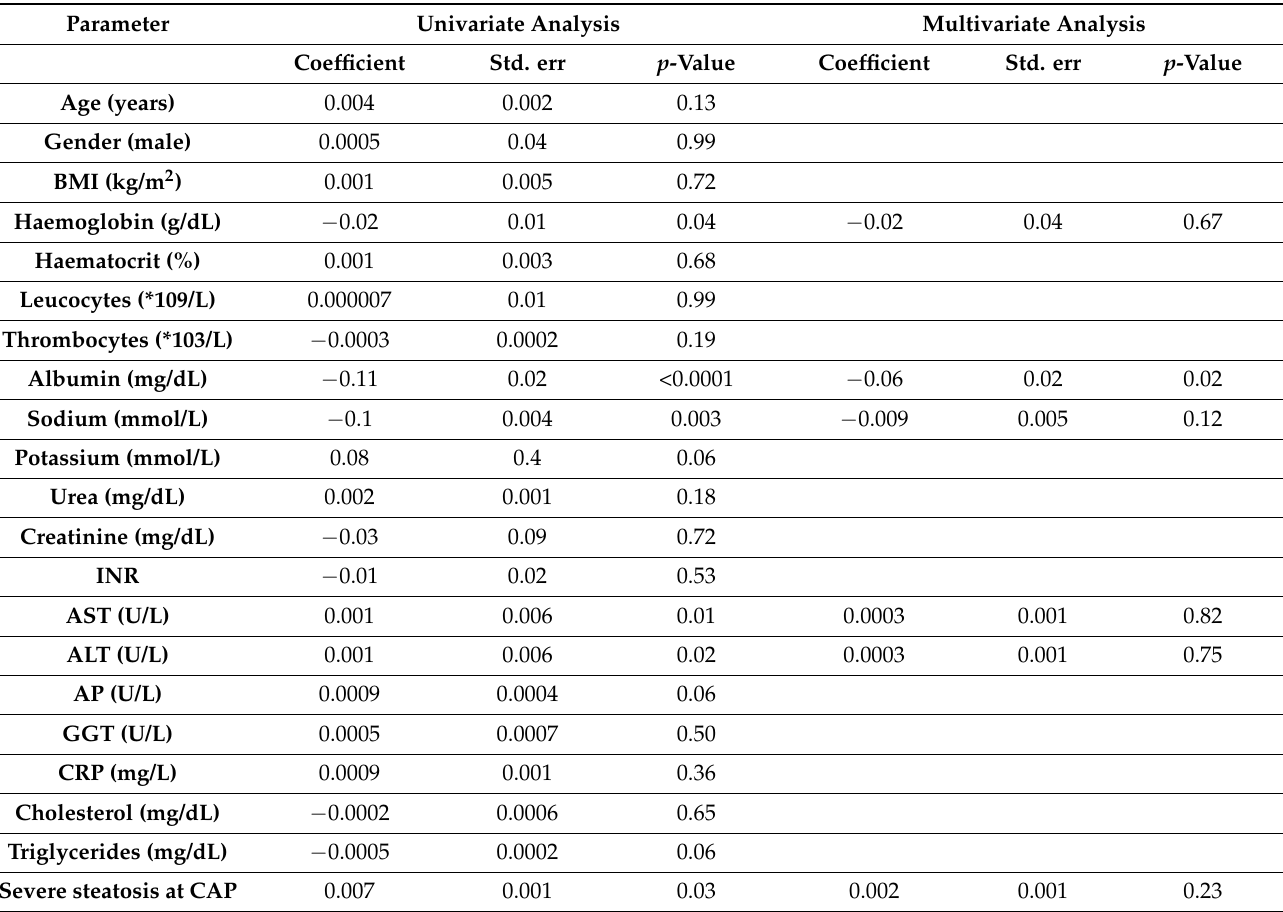
Table 4. The results of the generalised linear model (GLM) analysis applied to the clinical and paraclinical factors associated with the CEUS-PAT measurements. Significant factors in univariate analysis were included in the multivariate